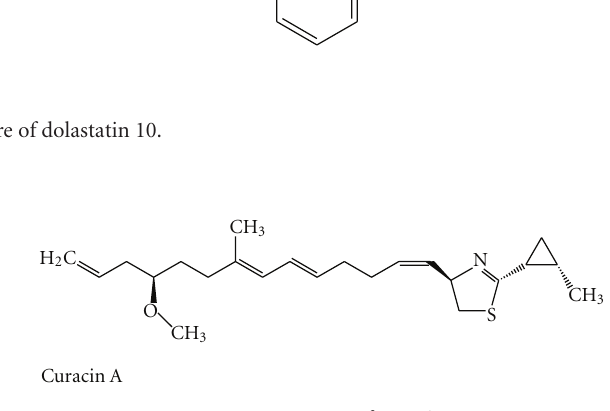
Figure 3: Structure of curacin